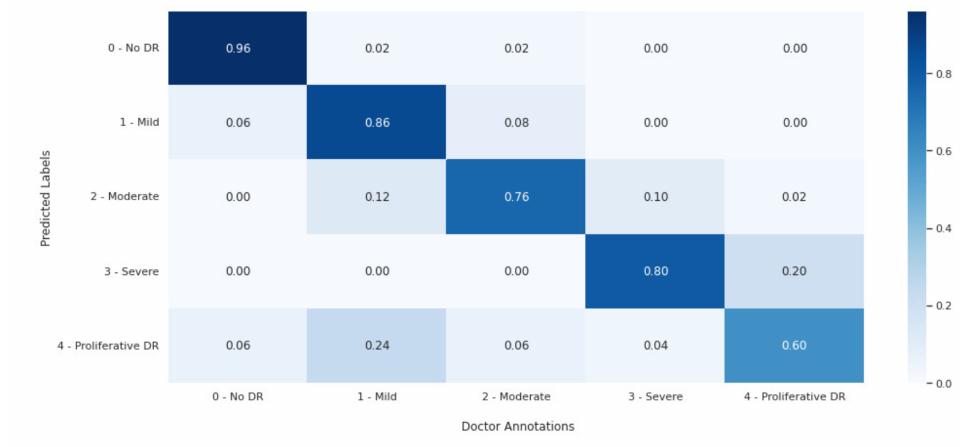
Figure 12. Confusion matrix for Mauritian data classified by